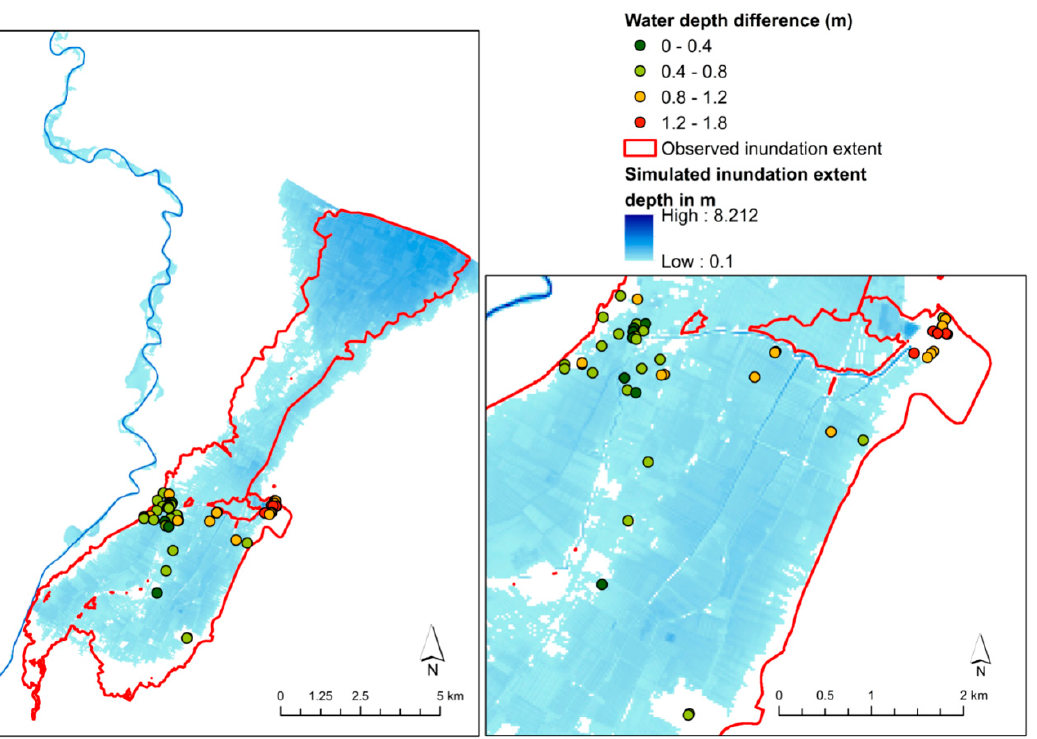
Figure 8. Simulated (blue) and observed (red) inundation extent.